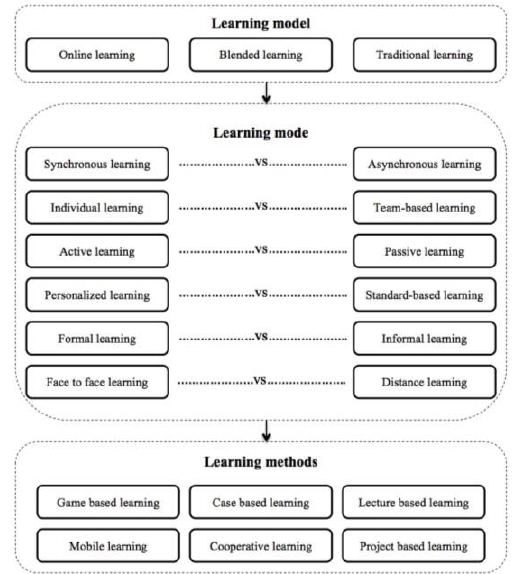
Figure 4 - A comprehensive learning